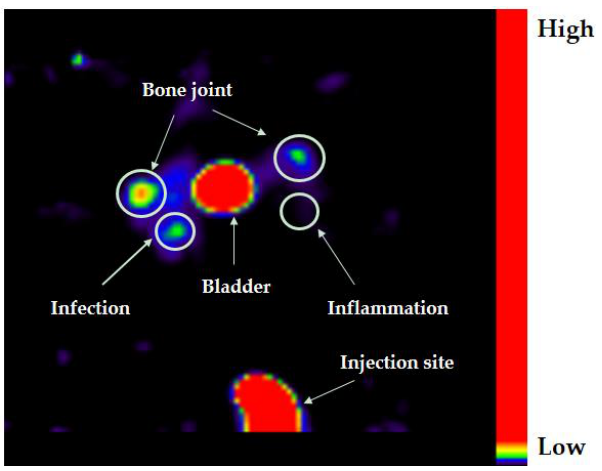
Figure 5. Half-body SPECT image of [ 99m Tc]Tc-CN5NF in female Kunming mice bearing infection and inflammation at 2 h post-injection (visual imaging).